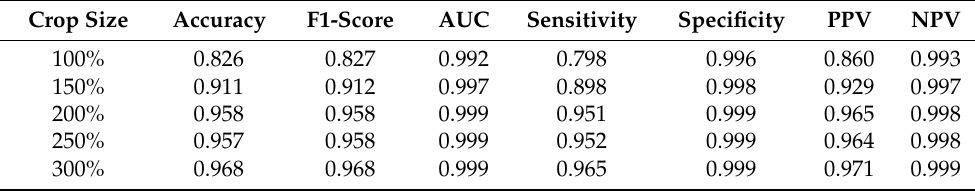
Table 2. Mean performance of the models on train set. Crop Size